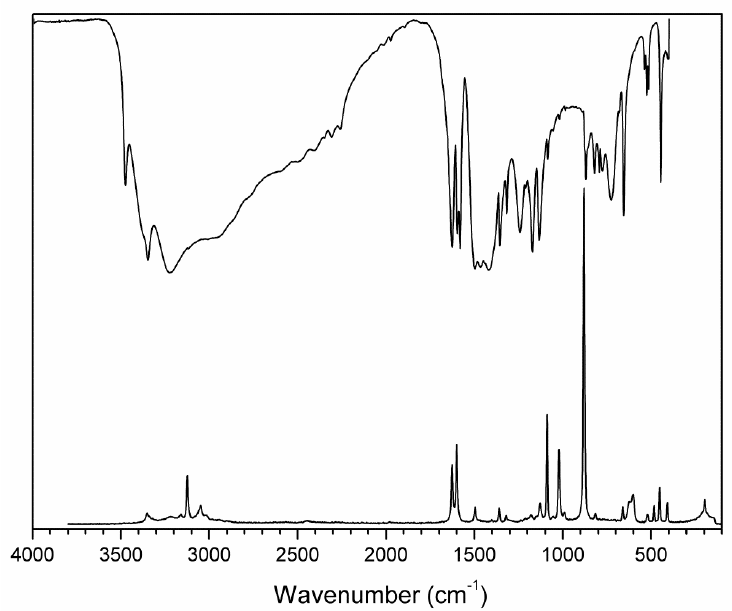
Abbreviations and Greek symbols used for vibrational modes: rg, ring; s , symmetric; ν , stretching; δ , deformation or in-plane bending; γ , out-of-plane bending; ρ, rocking; ω, wagging; τ , twisting; and X = N, O.